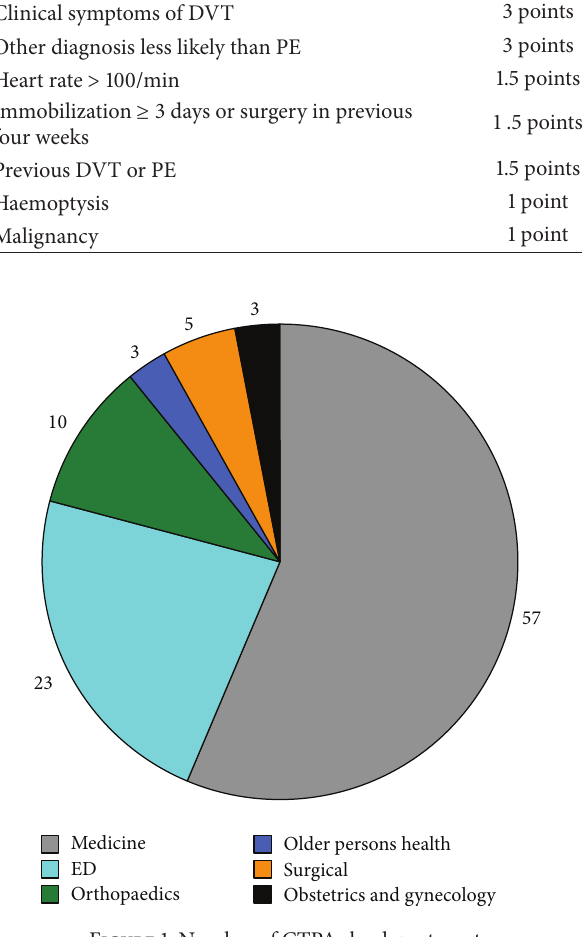
Figure 1: Number of CTPAs by